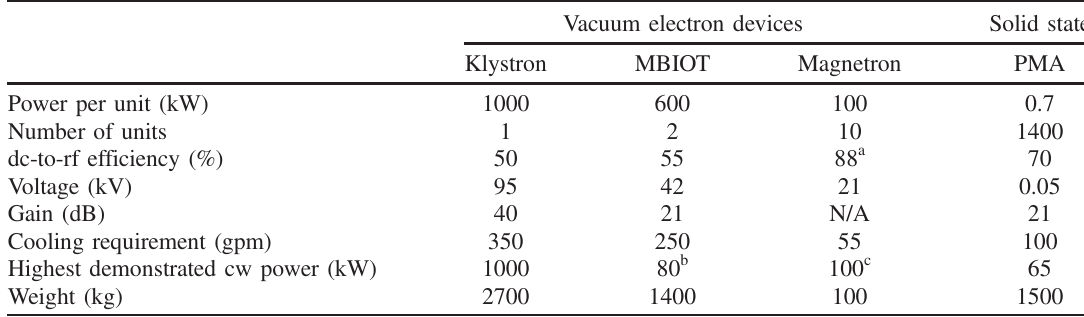
TABLE V. Summary of key performance and operating parameters for rf